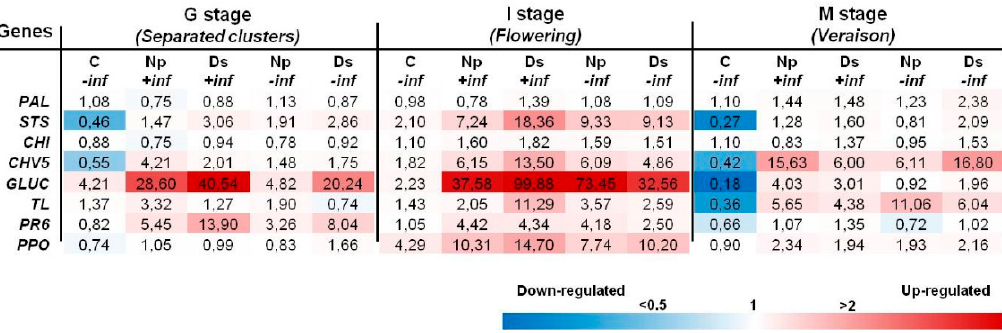
Figure 3. Expression levels of the considered eight genes recorded by RT-qPCR in N. parvum and D. seriata artificially-inoculated stems at different phenological stages. Values (the mean of three technical replicates) represent the expression levels ( ΔΔ C t) of reported conditions relative to the control (C + inf). The expression of a given gene was considered up- or down-regulated when the value of relative expression was >2-fold or <0.5-fold compared to the control, respectively.